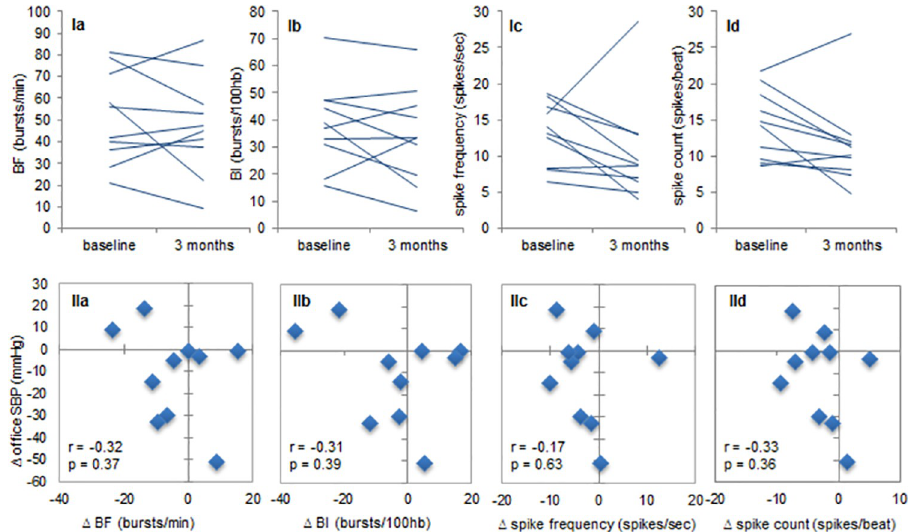
Fig 2. Individual MSNA changes and correlation with change in BP. Panel I: individual changes in burst frequency (Ia), burst incidence (Ib), mean beat-to-beat median spike frequency (Ic), and mean beat-to-beat spike count (Id). Panel II: correlation between change in office SBP and change in burst frequency (Ia), burst incidence (IIb), mean beat-to-beat median spike frequency (IIc), and mean beat-to-beat spike count (IId). Observations in the left lower quadrants of the plots support baroreflex-mediated BP reduction. SBP = systolic blood pressure, BF = burst frequency, BI = burst incidence, r = Pearson’s correlation coefficient, p = p-value.